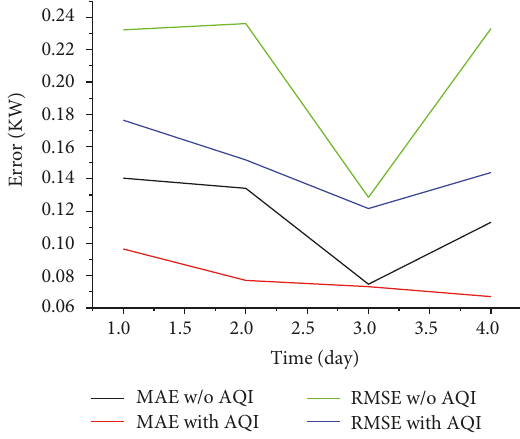
Figure 6: Errors during haze